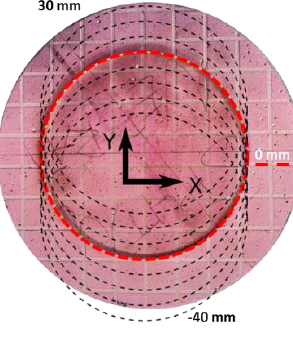
Fig. 7. Different Tool-Workpiece positions.